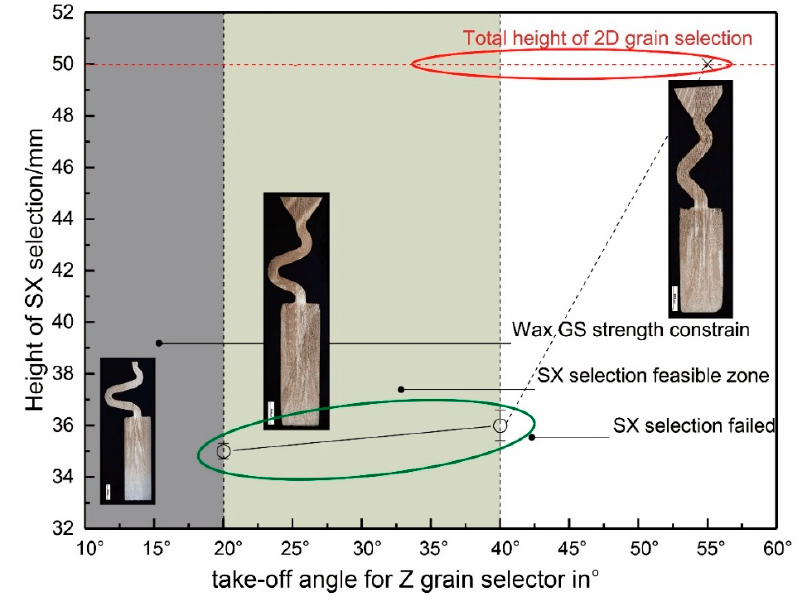
Figure 7. The relationship between heights of SX position and the take-off angle of the grain selector portion.